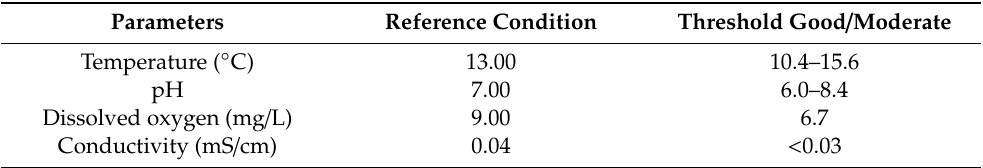
Table 2. Reference Condition in Cantabric-Atlantic siliceous rivers.